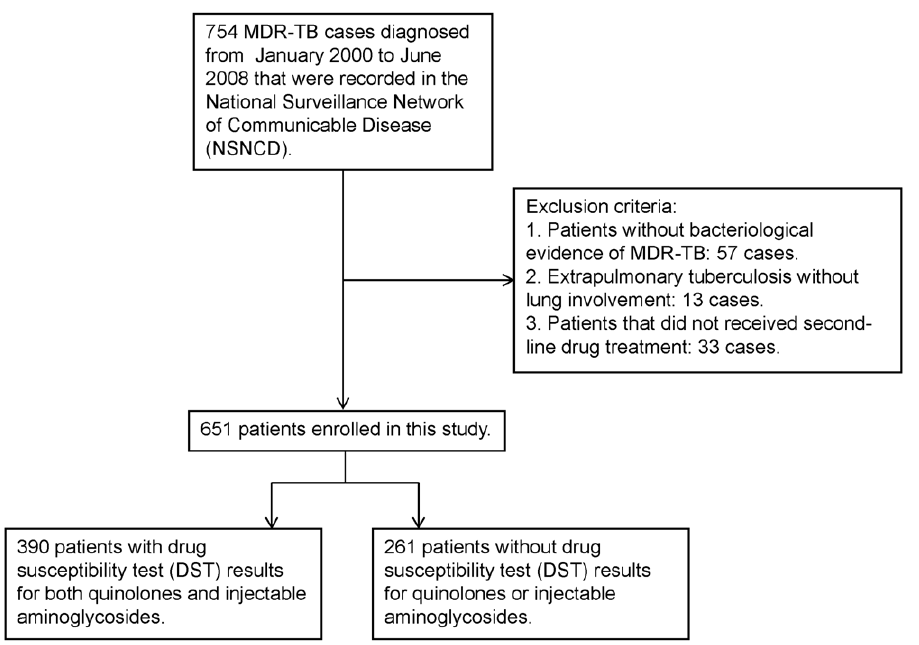
Figure 1. Patient selection. NSNCD, National Surveillance Network of Communicable Disease. MDR, multiple-drug resistance; TB, tuberculosis.